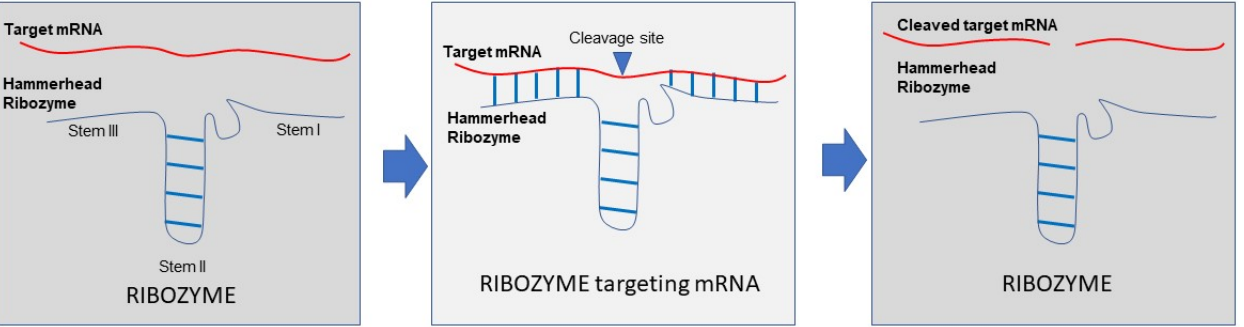
Figure 1. Schematic representation of hammerhead ribozymes mechanism of action.